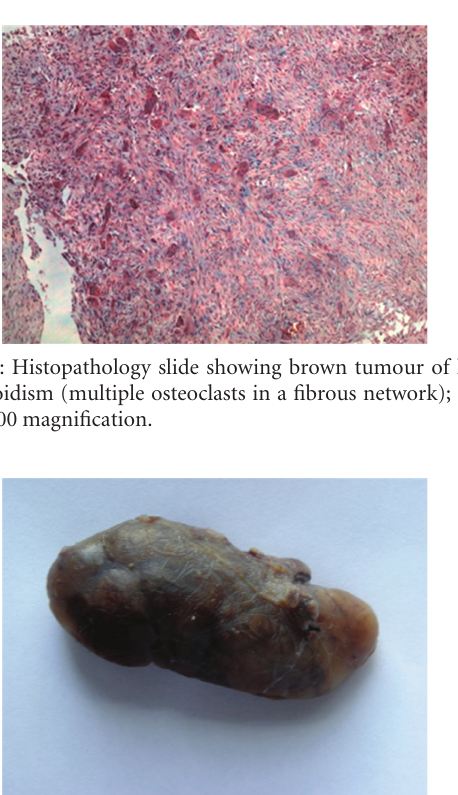
Figure 4: A gross specimen of one the parathyroid adenomas (whole).